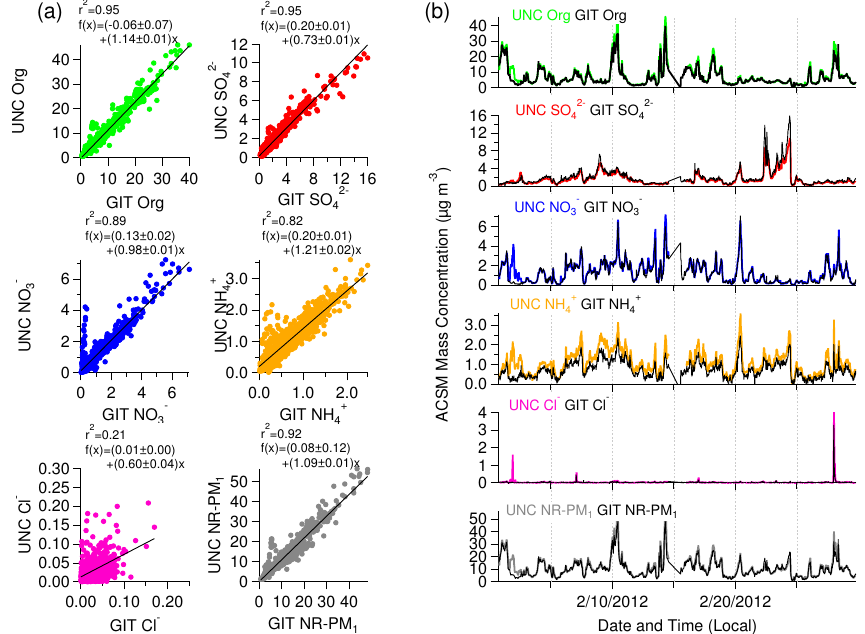
Figure 1. (a) Linear regression correlation and (b) time series plots of organic and inorganic constituents measured by the UNC and GIT ACSMs. ACSM measurements from UNC are colored by species while those from GIT are colored in